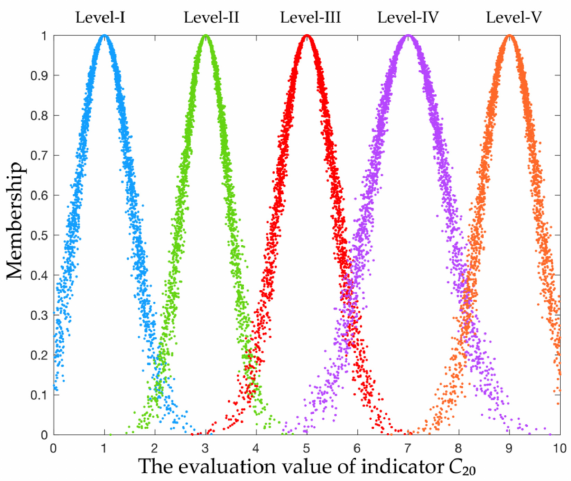
Figure 3. Hierarchical normal cloud model based on cloud entropy